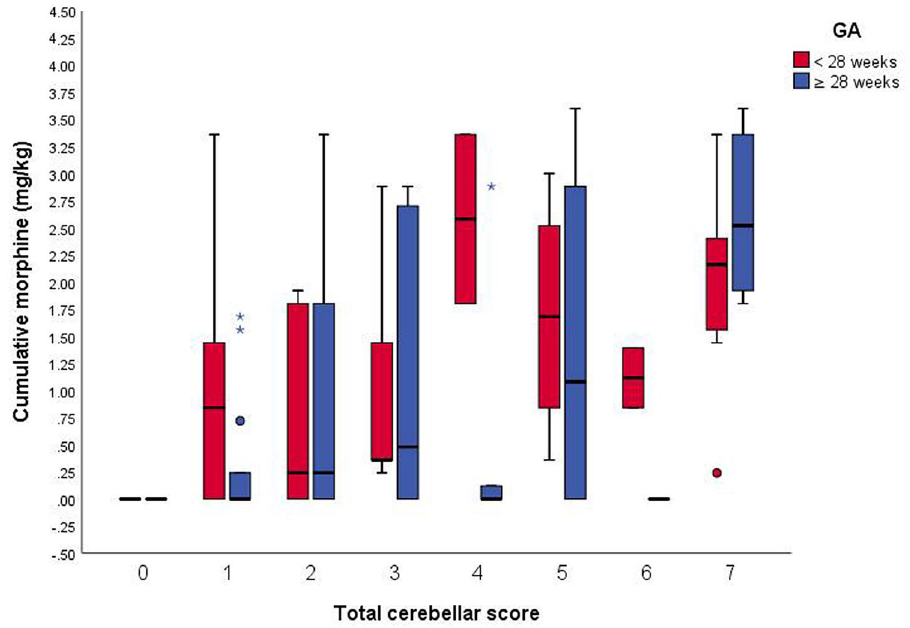
Figure 3. Total cerebellar score by morphine exposure, adjusted for age at the time of magnetic resonance imaging and stratified by gestational age (GA) at birth (red: < 28 weeks, blue: ≥ 28 weeks). GA Gestational